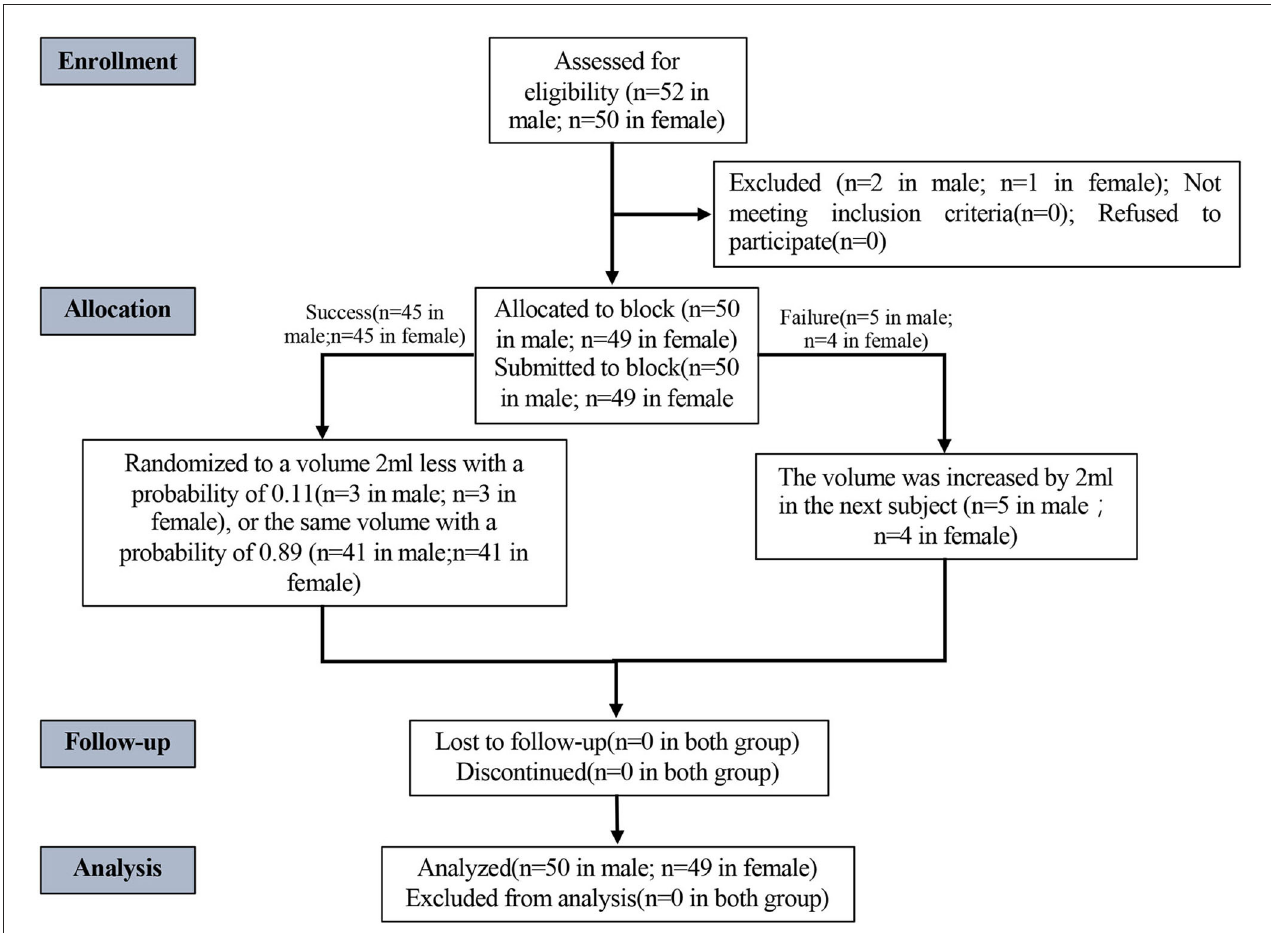
FIGURE2 CONSORT